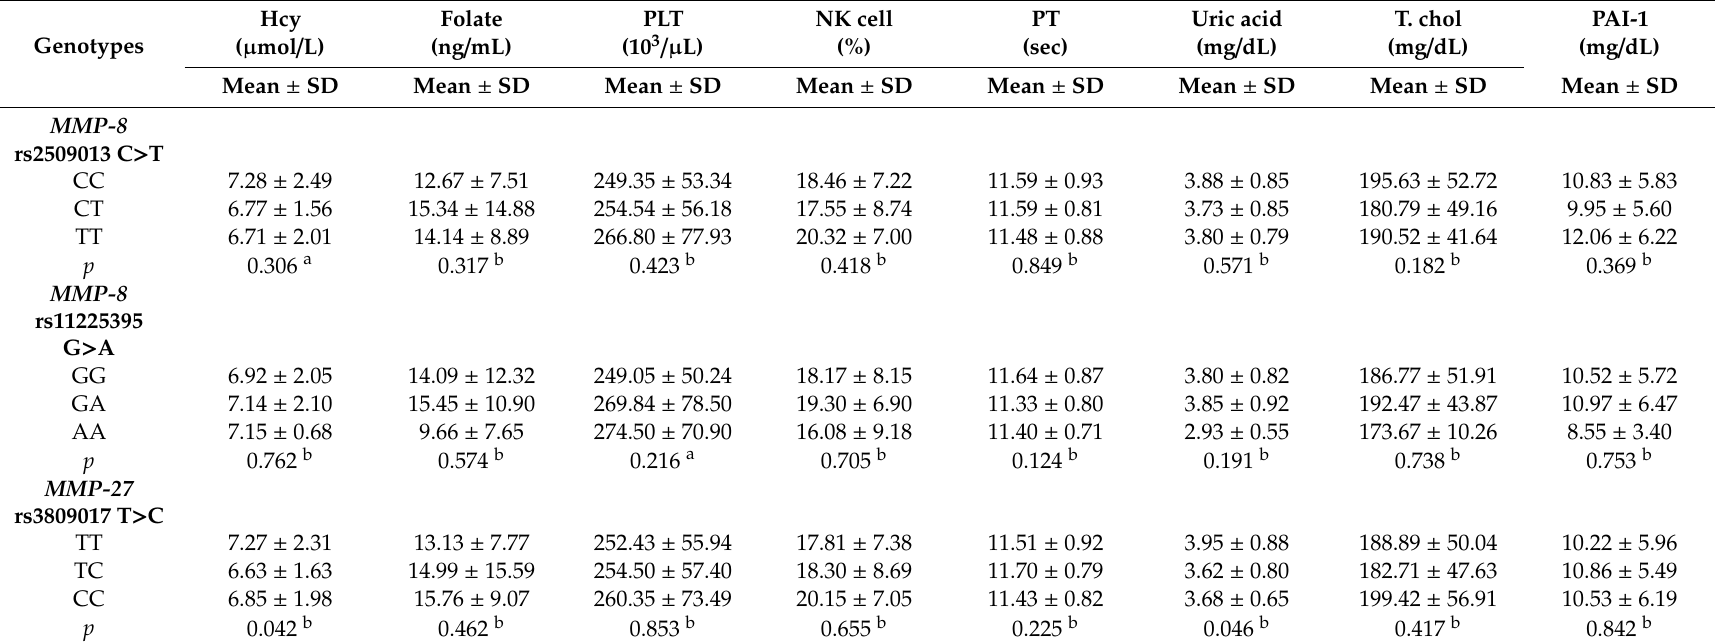
Table 5. Di ff erences in the clinical parameters according to genotype of MMP gene polymorphisms in the RPL patient